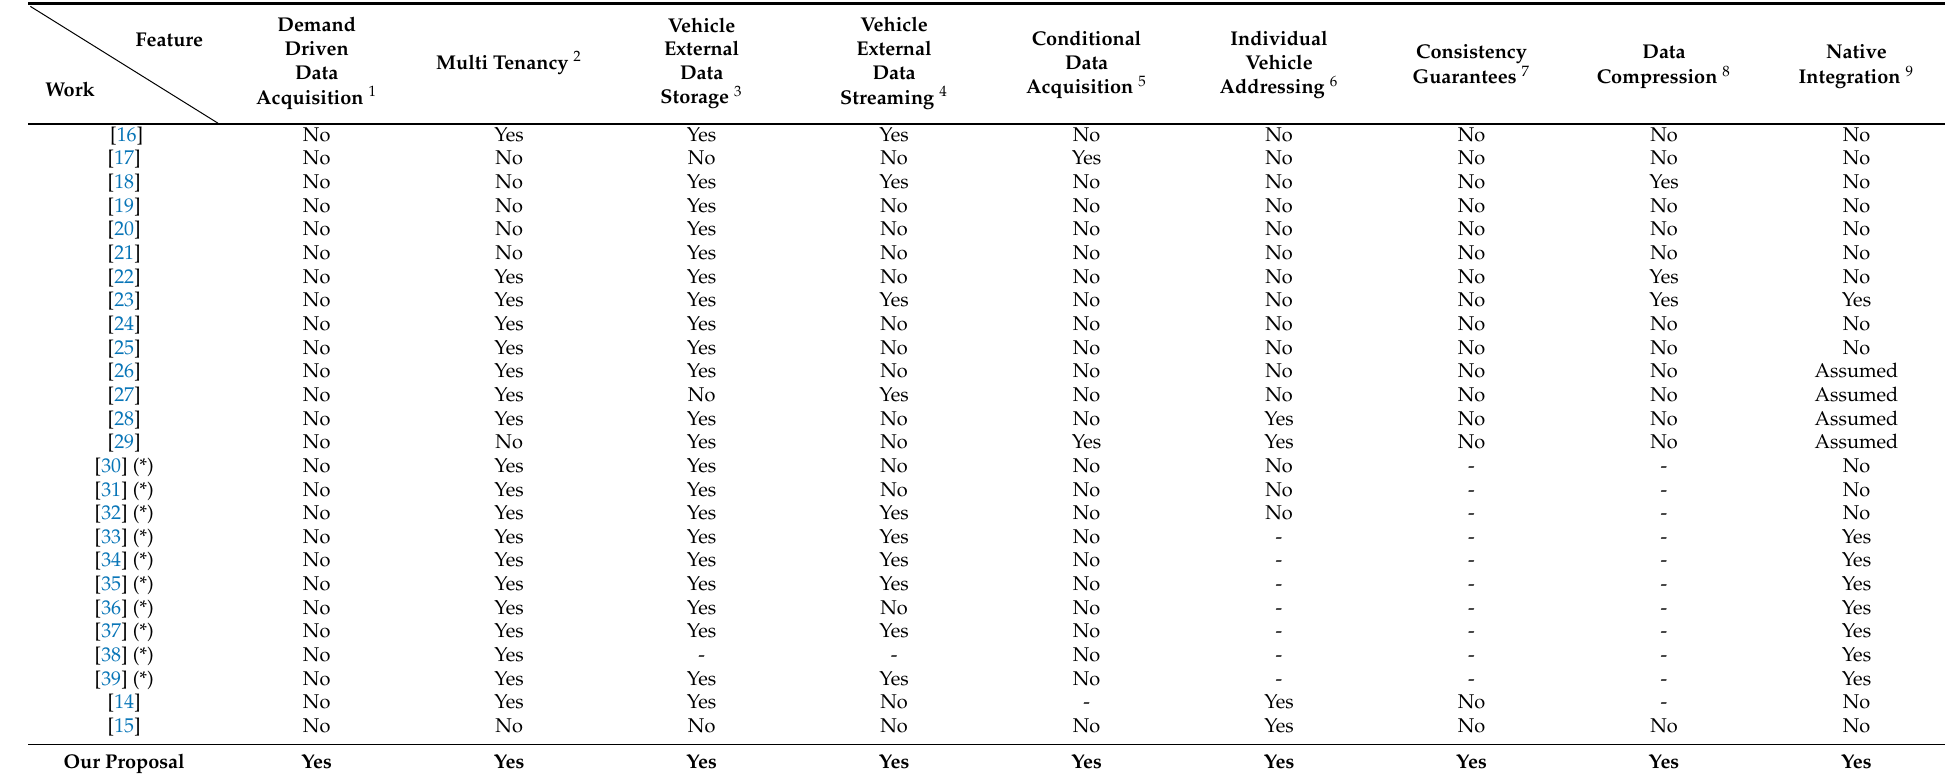
Table 1. Overview of closely related data acquisition systems regarding selected features, including commercial closed-source products, which are marked with an asterisk. Features that are not evident from their public documentations are marked with a dash. There are also architectural concepts that assume a native integration but have not integrated their architecture into a vehicle yet. Some systems include programmable hardware; in this case, we only consider software and cloud platforms provided by the manufacturer